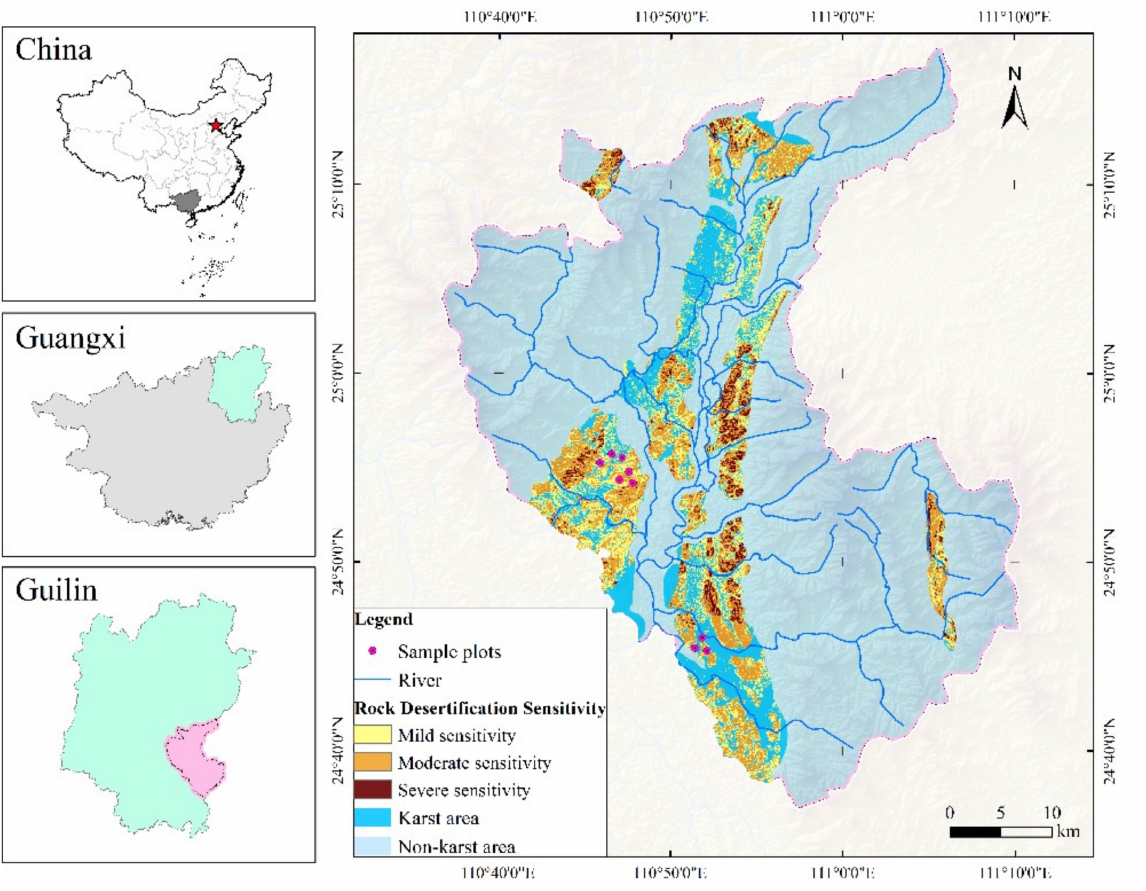
Figure 1. Sampling points distribution of plant